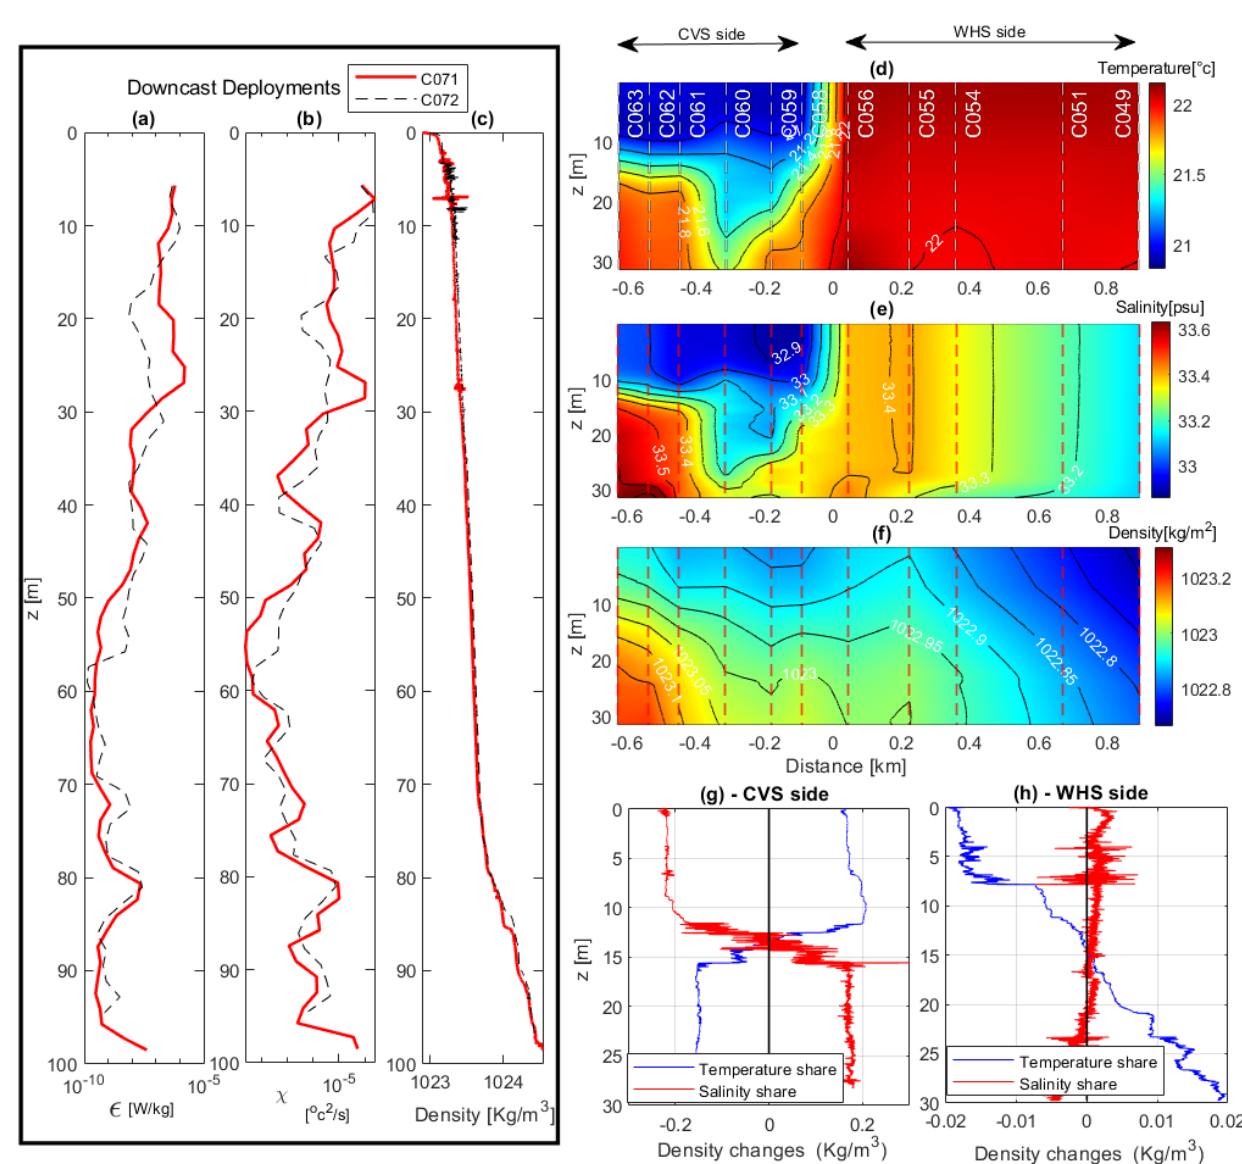
Figure 2. The vertical profiles of the VMP200 deployments on the cold-vertically stratified (CVS) Mississippi River water side are shown in a black box for downcasts C071 and C072. ( a ) Turbulent kinetic energy dissipation rate (TKED) (or (cid:101) ), ( b ) temperature dissipation (TD) (or χ ), and ( c ) water density. VMP200 derived transects of the front when the instrument was deployed using the upcast technique are shown in graphs ( d ) temperature, ( e ) salinity, and ( f ) density. The arrows above the ( d ) present the CVS and warm-horizontally stratified (WHS) Gulf of Mexico water sides. The vertical dashed lines present the location of deployments, and the zero distance shows the location of the front center. The relative contribution of salinity and temperature to density are shown on ( g ) the CVS (C060) and ( h ) WHS (C054)